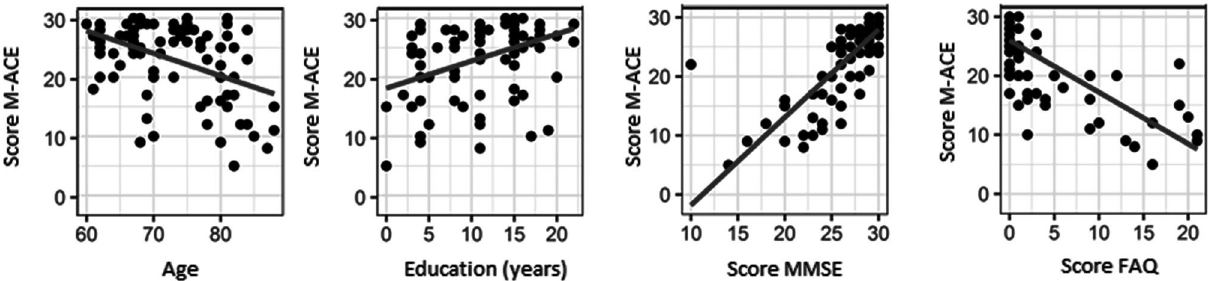
Figure 3. Scatter plots of M-ACE for age, education, MMSE and